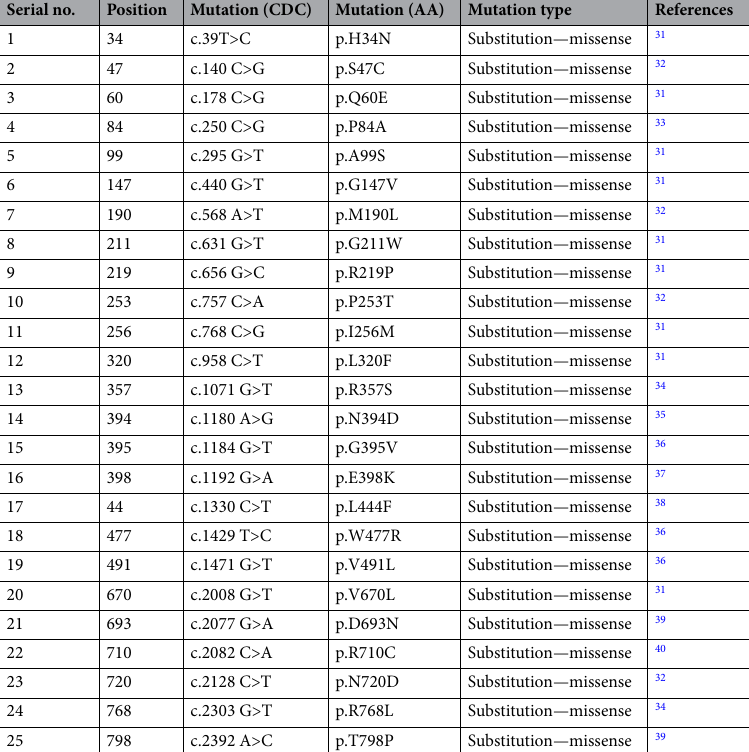
Table 3. High stability and strong binding affinity between two interacting proteins in a complex are indicated by a smaller Kd value 43 . Spike protein-ACE mutants showed high stability and binding affinity as the tempera- ture rises, and at the optimum temperature, stability and binding affinity became constant. Whereas the lowest protein stability and binding affinity were seen at 25 ℃ , and highest on the optimum temperature (Table 3, Tables